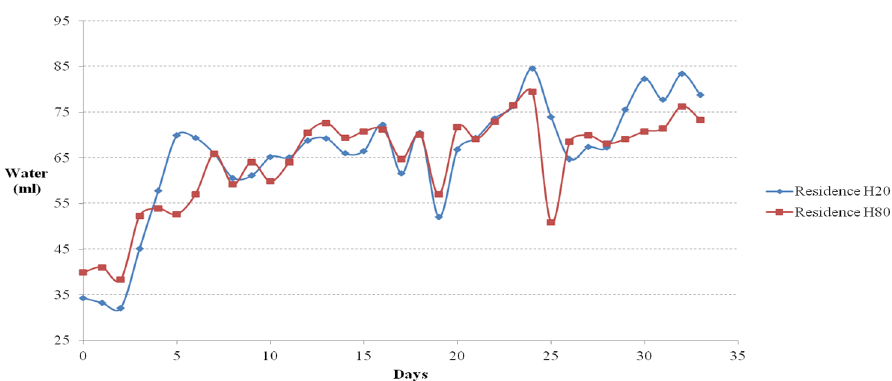
Figure 14. Water intake versus time curves (residence cages).